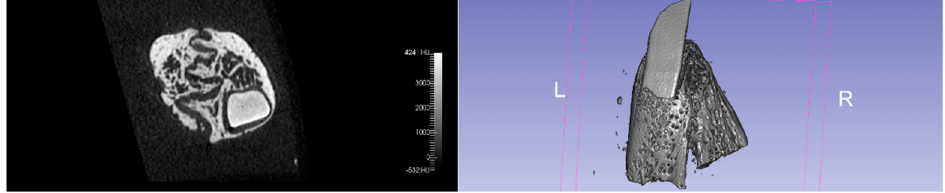
Figure 1. Coronal section and tridimensional reconstruction of the control group extractive socket at a 90-day evaluation. a 90-day